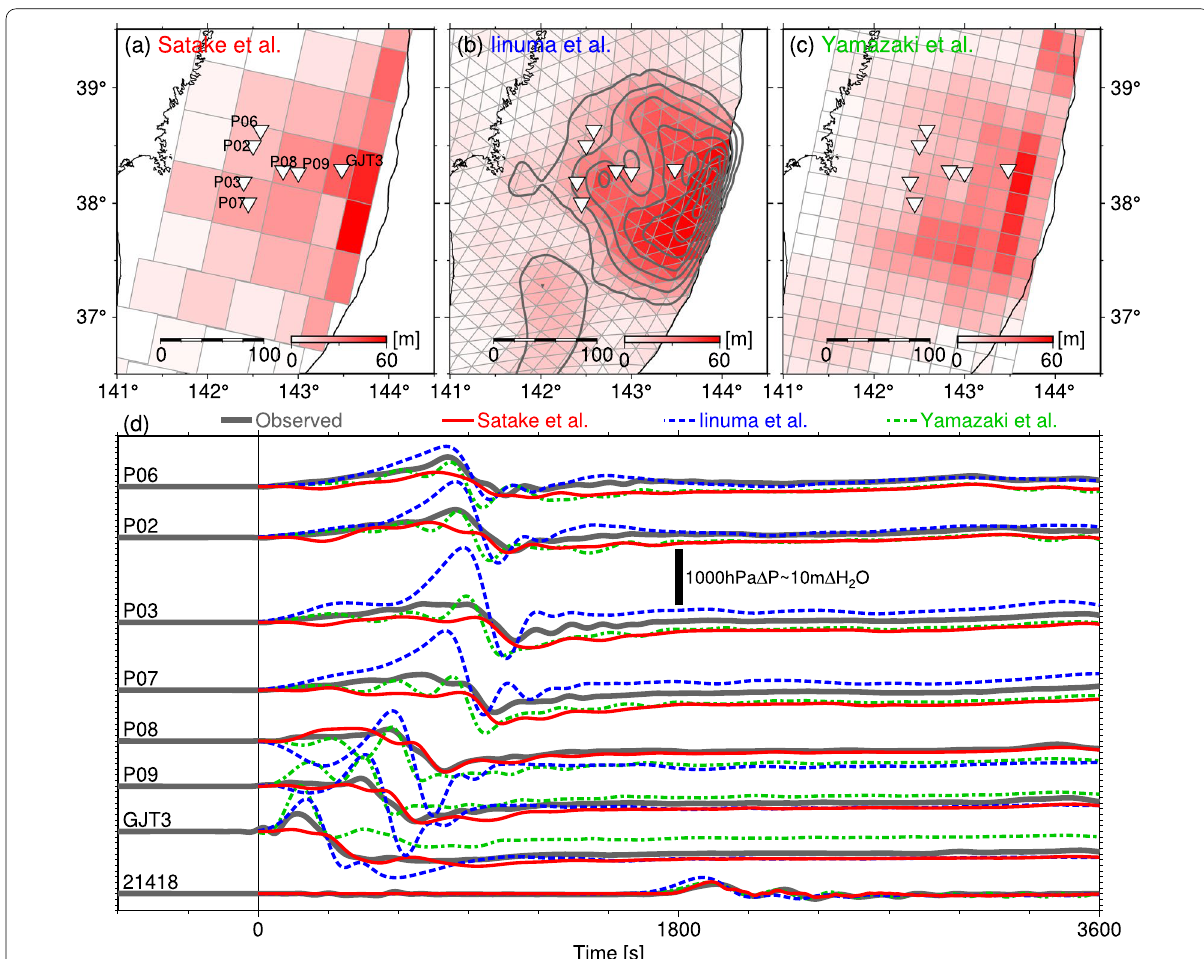
Fig. 9 Tsunami simulation results of previous fault models of the Tohoku earthquake. a – c Slip distribution and initial sea-surface height distribution assumed from the fault model proposed by Satake et al. (2013), Iinuma et al. (2012), and Yamazaki et al. (2018), respectively. d Comparison between the observed (gray) and simulated waveforms (colored) at representative